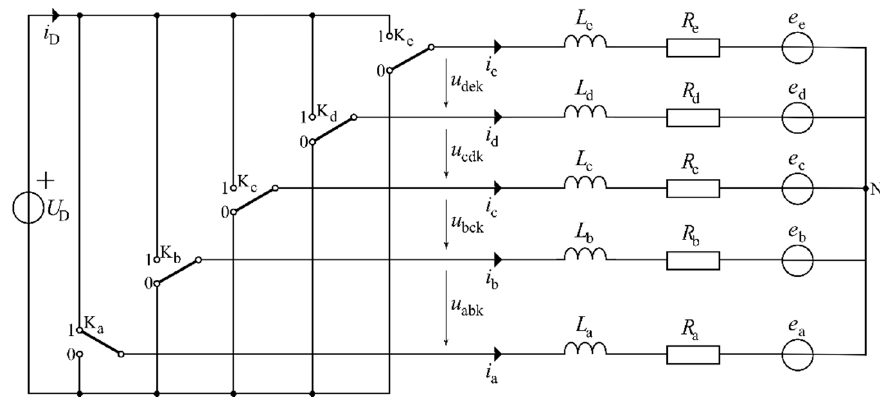
Figure 4. The model of the five-phase two-level inverter with the load.